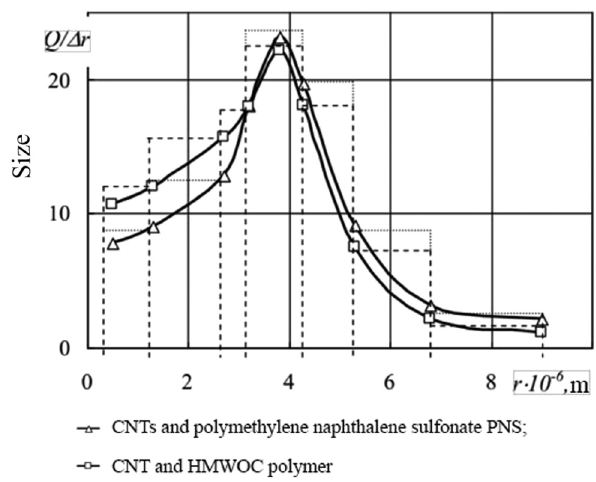
Figure 5: Kinetics of CNT sedimentation dispersed in the medium: HMWOC polymer, tap water, superplasticizer.